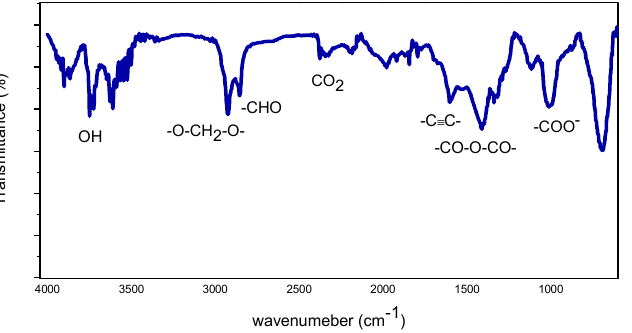
Figure 10. ATR-FTIR spectrum of 3Al,3Ca doped ZnO sensor after contact with Figure 10 . ATR-FTIR spectrum of 3Al,3Ca doped ZnO sensor after contact with HCHO.